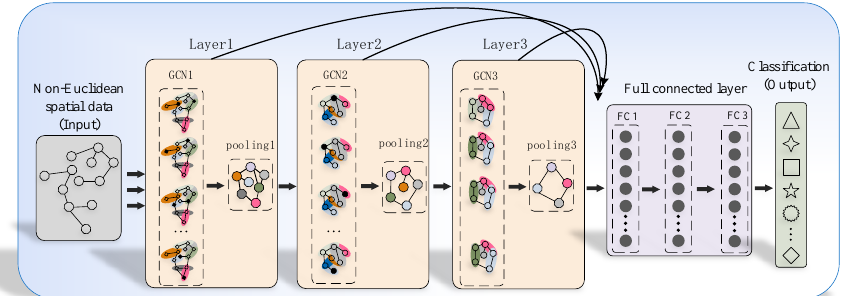
Figure 3. The graph convolutional neural network proposed in this